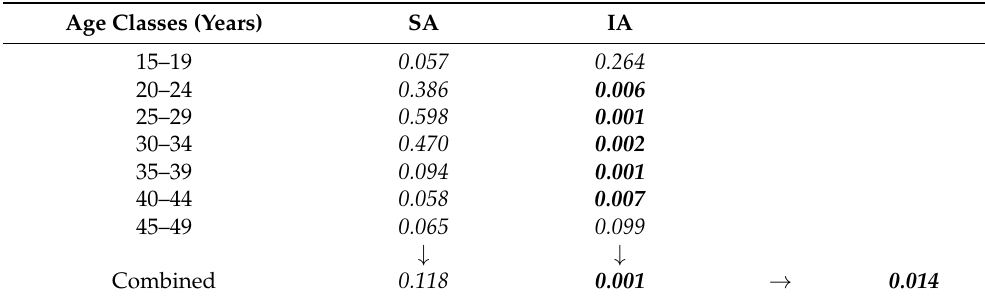
Table 3. Partial and combined p -values of comparison among macro-areas, stratifying for age